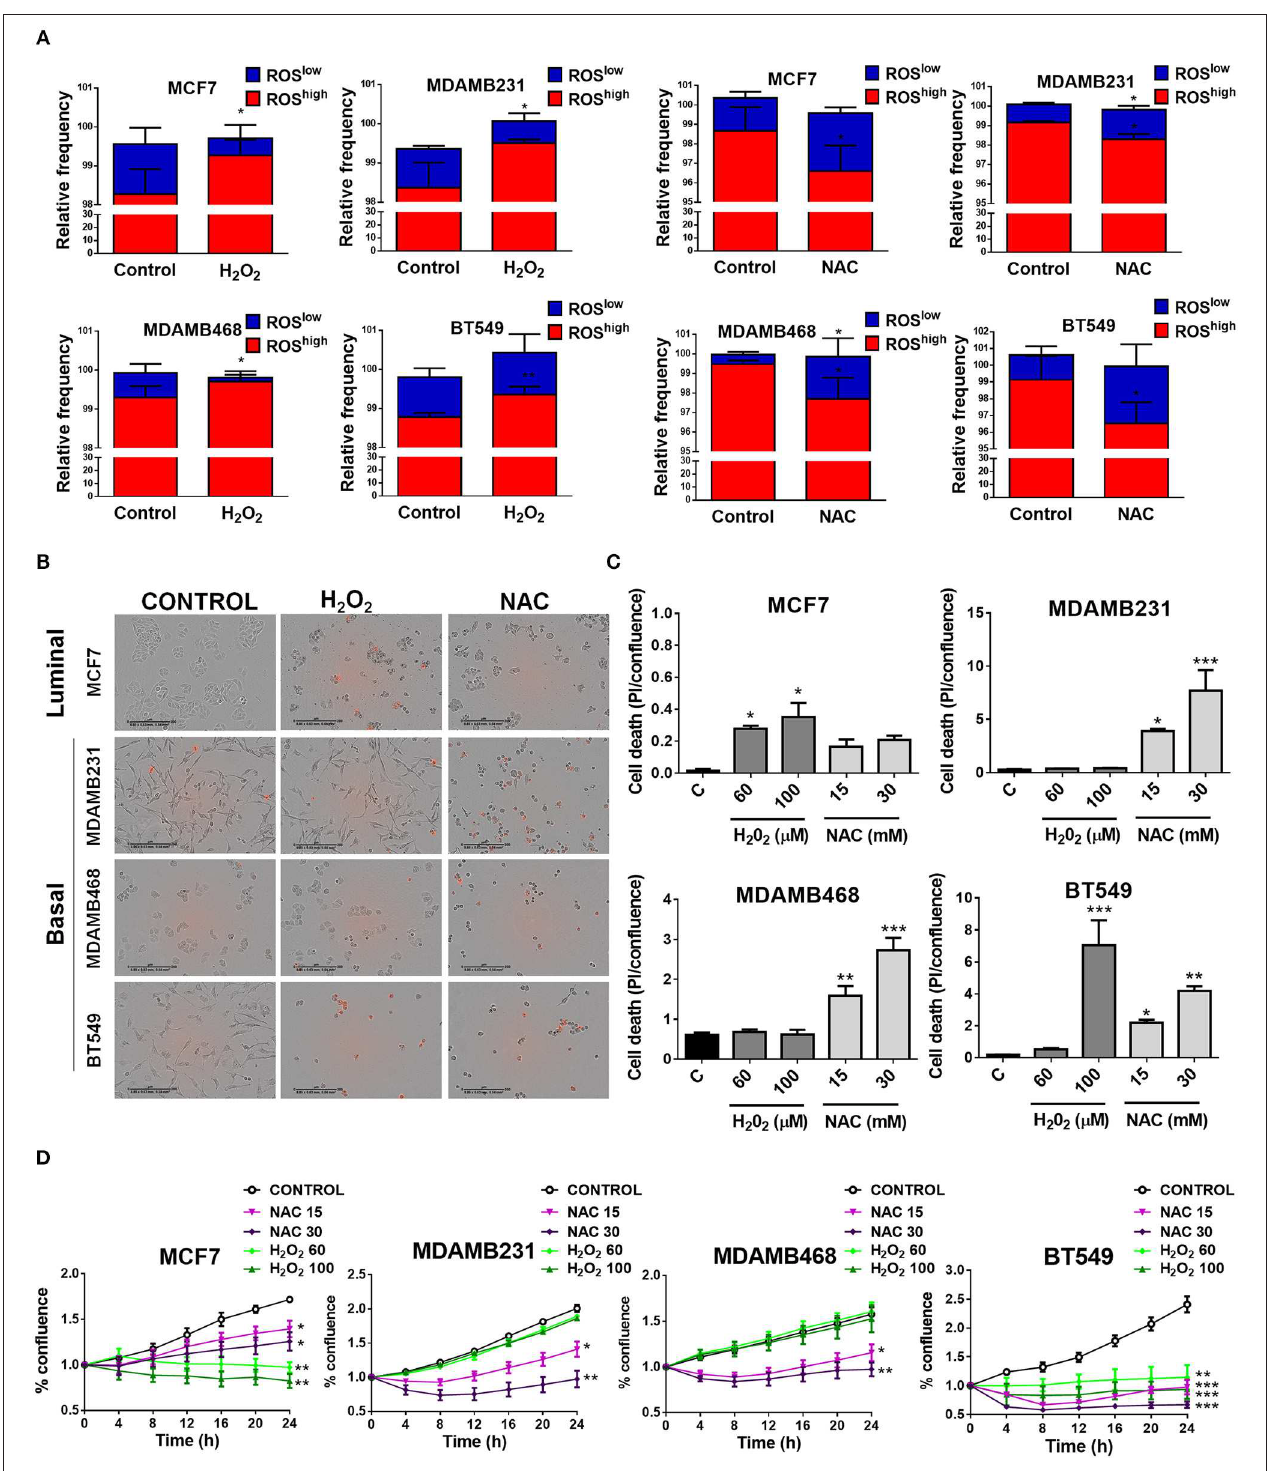
FIGURE 4 | Basal, TNBC cell lines are dependent on ROS for survival. (A) Cells were treated with oxidating conditions (H 2 O 2 ) or with an antioxidant (NAC, N-acetyl cysteine) at the indicated concentrations. One hundred micromolar H 2 O 2 treatment increased the ROS high or decreased the ROS low population and 30mM NAC had the opposite effect in all breast cancer cell lines studied. (B,C) Cell death was evaluated as propidium iodide staining [% confluency of PI( + ) cells] and normalized to total % confluency. (D) Cell proliferation was evaluated as changes in cell confluency in an Incucyte real time cell imaging system. Graphs show mean ± SEM of more than 3 independent experiments. *different to control, p < 0.05; **different to control, p < 0.01; and ***different to control, p < 0.001.